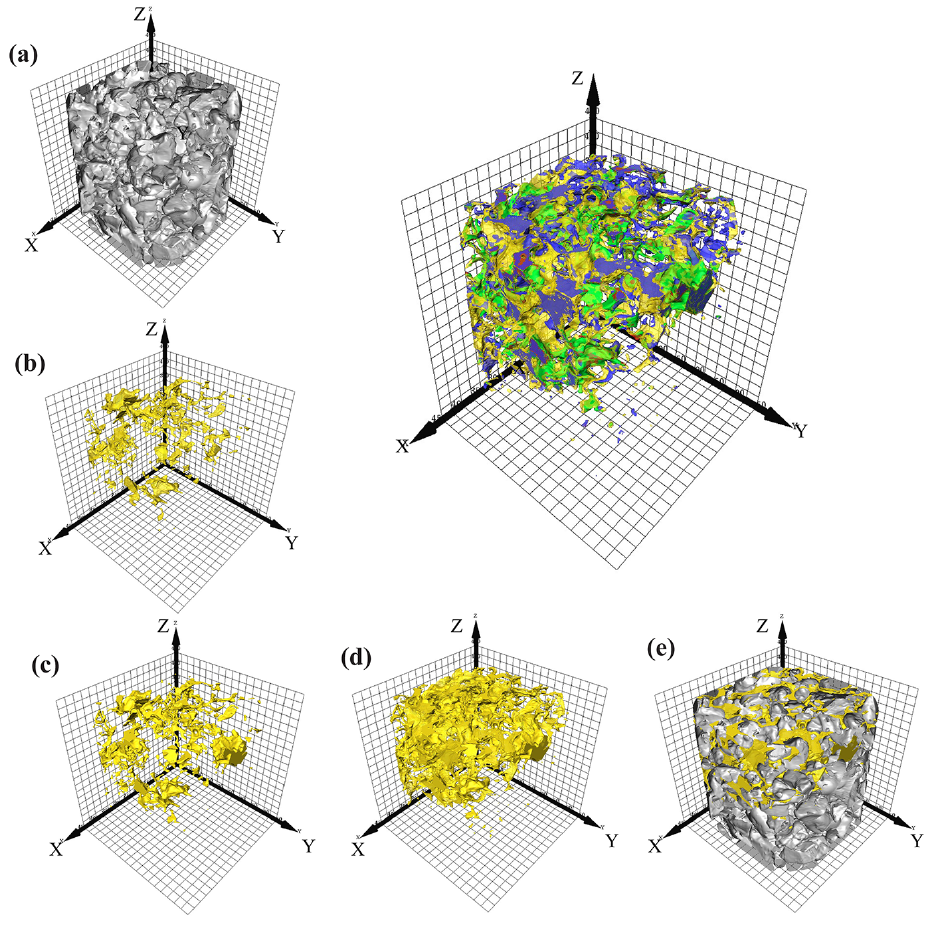
Figure 10. Series of hydrate formation visualized in 3-D. For this a region of interest of 400 × 400 × 400 was picked: (a) initial state where no hydrate is present; (b) and (c) hydrate formation starts and proceeds from a free-gas environment; (d) full-transformation state; (e) full- transformation state embedded in the sedimentary matrix. The figure in the center shows all hydrate formation steps within one image where some steps are set on α -scale transparency to gain information on hydrate structures beneath.